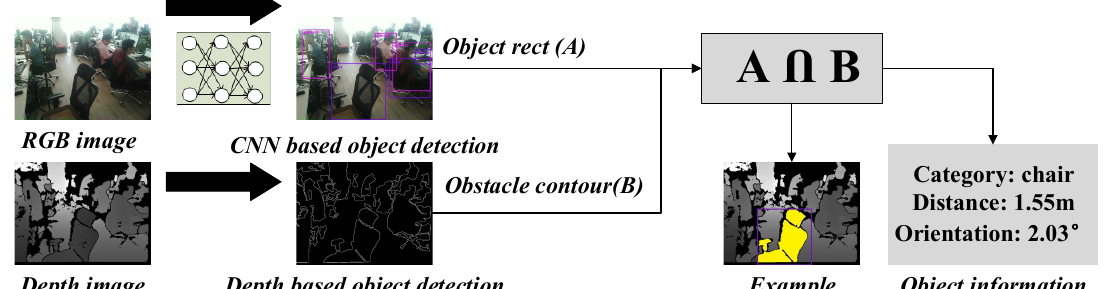
Figure 8. 2.5-D object detection (the yellow region (i.e., C in Equation